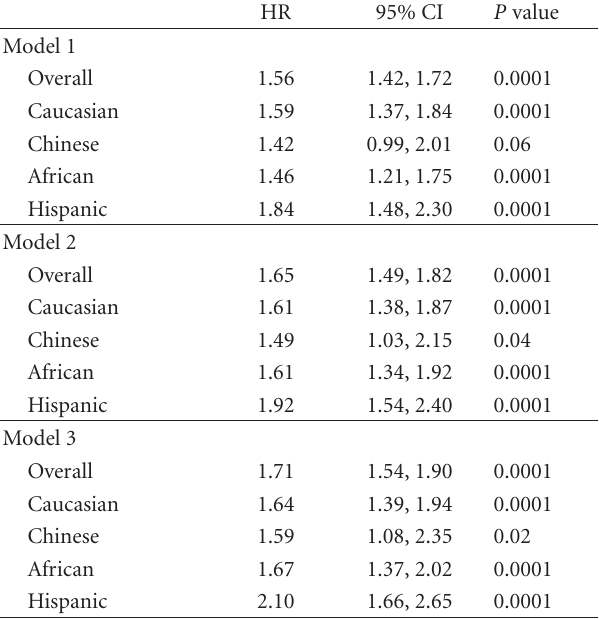
Table 3: Cox proportional Hazard models illustrating the asso- ciation of MetS-PC per change in one SD with CVD events in the MESA cohort after 5.5 years of follow up overall and by